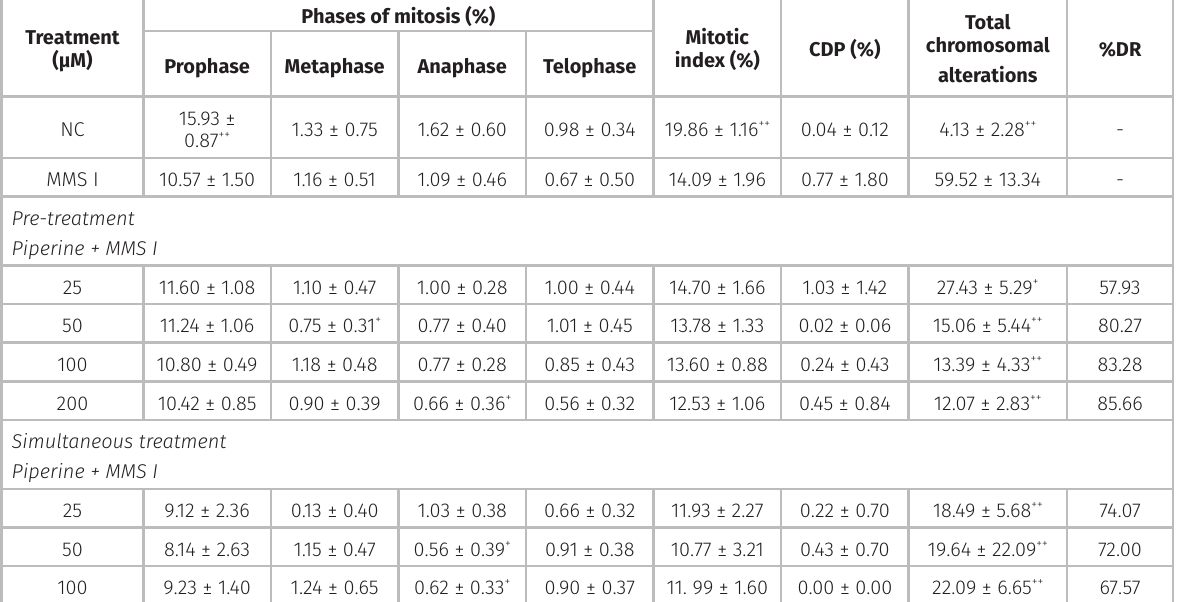
Table III. Phases of mitosis, mitotic index, cells in death process (CDP) and total chromosomal alterations and percentage of damage reduction (%DR) in meristematic cells of A. cepa exposed to different concentrations of piperine or